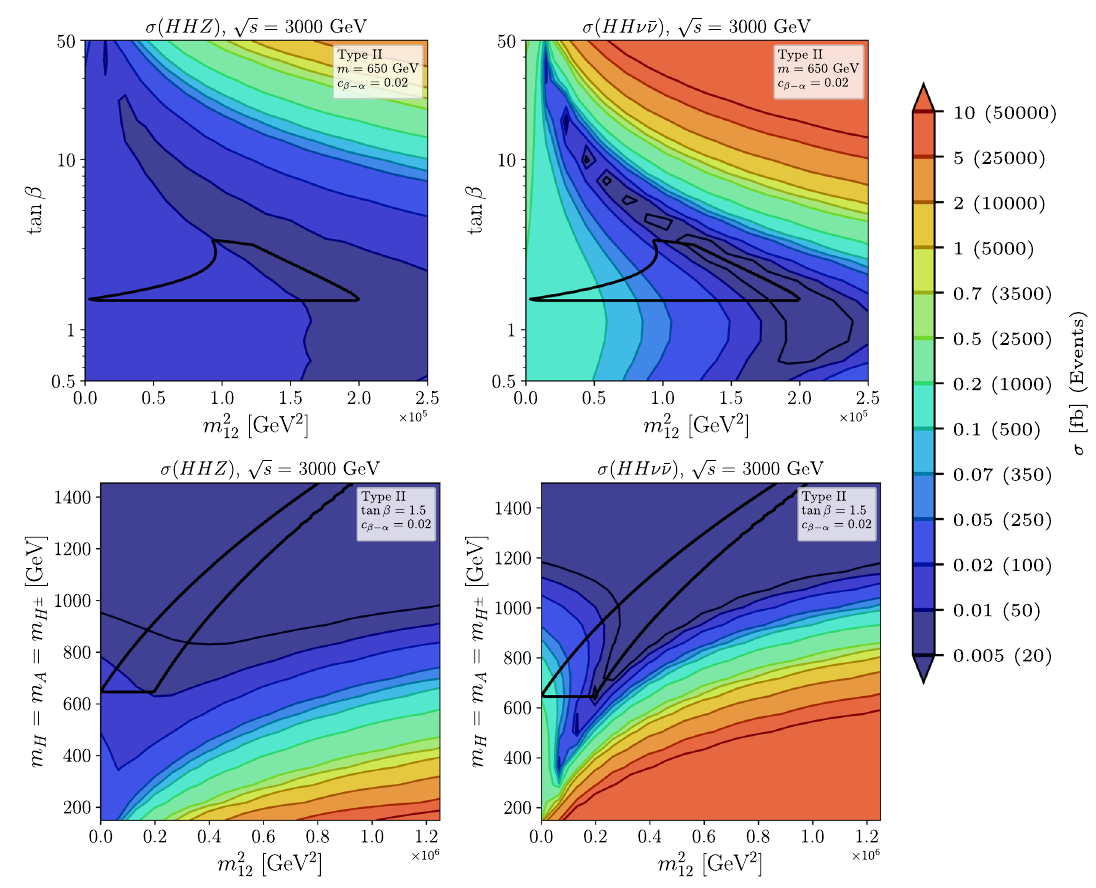
√ s = 3000 GeV for our benchmark planes 4, 5 (top, bottom).